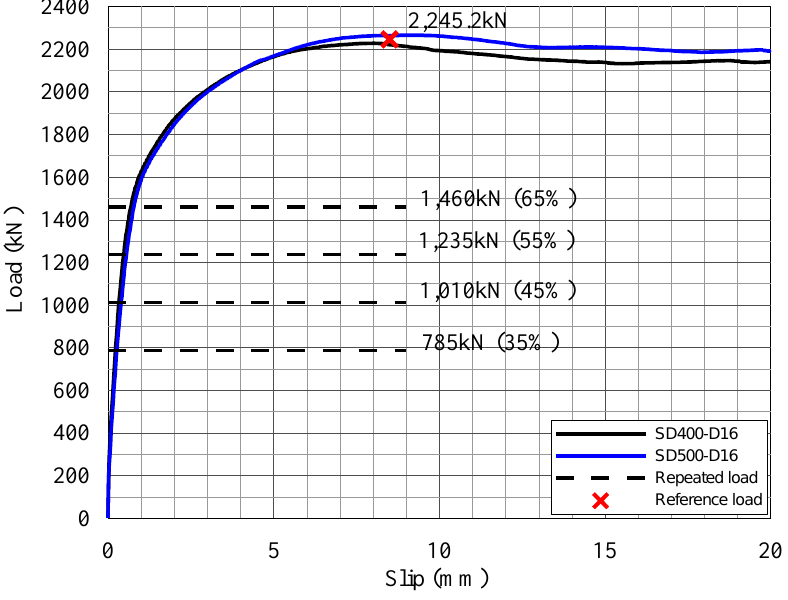
Figure 8. Range of the intensities of repeated